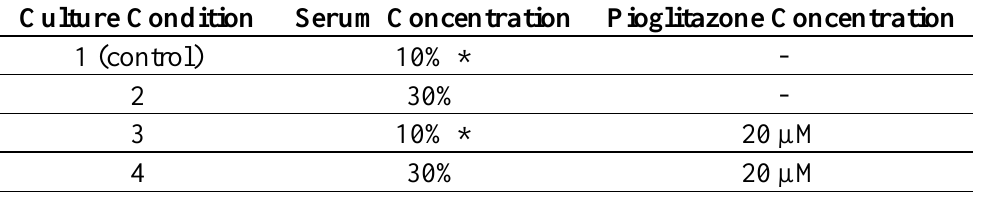
Table 2. Incubation of MCF-10A cells with low glucose DMEM growth media supplemented with pioglitazone and/or serum at the appropriate concentrations, as described in the Table, for 1 week. The concentrations of pioglitazone and serum used in this study were optimised as described in the results